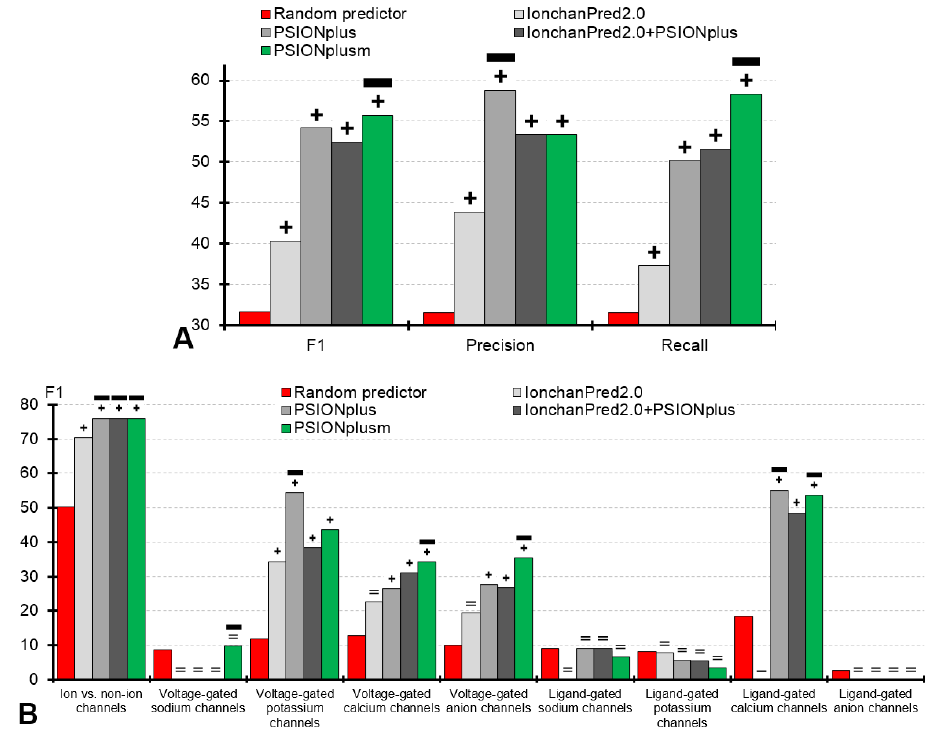
Figure 3. Predictive performance for the sequential prediction with PSIONplus m , IonchanPred2.0, PSIONplus, combination of predictions from IonchanPred2.0 and PSIONplus (IonchanPred2.0+PSIONplus) and the random predictor (implemented by shuffling of actual labels) on the benchmark dataset. Panel ( A ) summarizes the values of F 1 , precision, and recall metrics for the multi-label prediction of channels and their types. Panel ( B ) shows F 1 values for individual outcomes including the prediction of ion channels and their 8 types/subtypes. Annotations above the bars denote the statistical significance of the differences between the random prediction and each of the four predictors, where +, -, and = denote that a given predictor is significantly better, significantly worse, and not significantly different to the random predictor. The thick horizontal black lines identify the ion channel predictors that outperform the random predictor and which are statistically significantly better than the other channel predictors for a given label. We assume that the difference is significant when p -value < 0.001. Calculation of significance is explained in the footnote in Table 3.